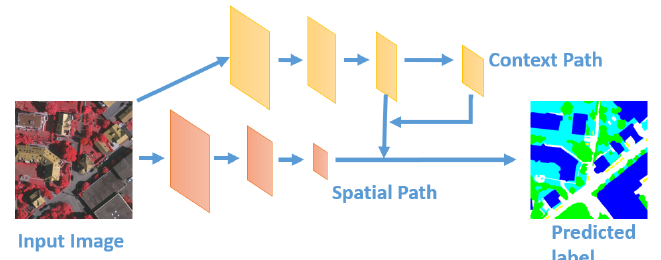
Figure 8. Architecture of the bilateral segmentation network